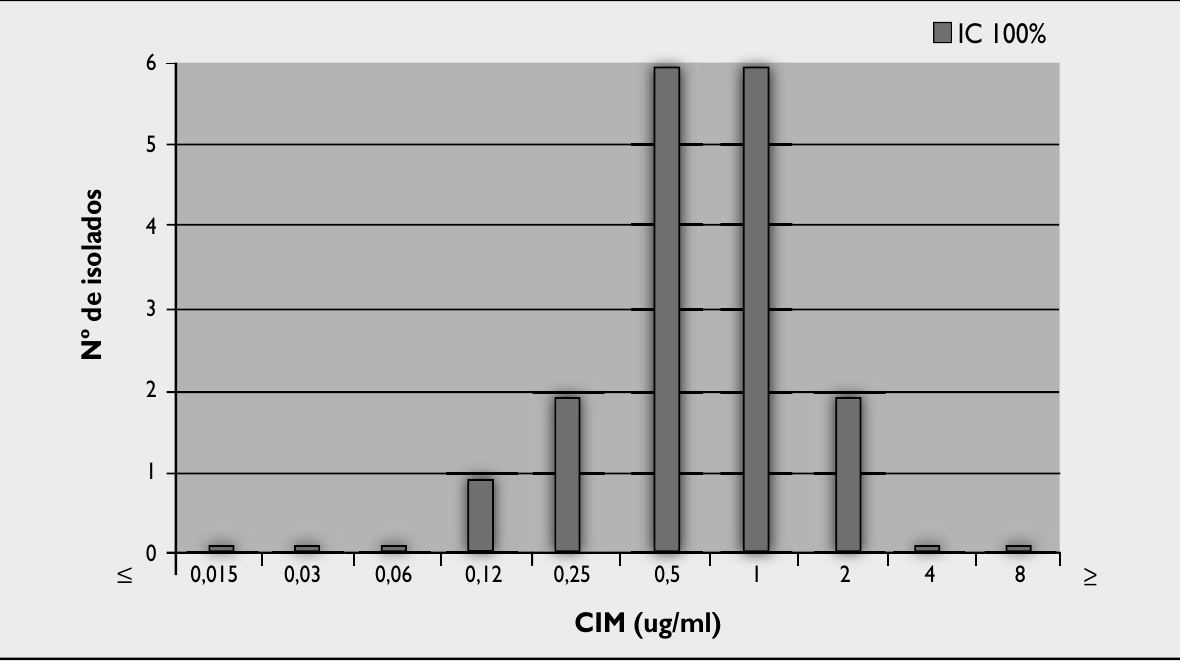
Figura 6 – Distribuição dos valores de CIM de anfotericina B, calculados para índice de inibição de 100%, em isolados de espécies não- albicans do fl uido vaginal de 17